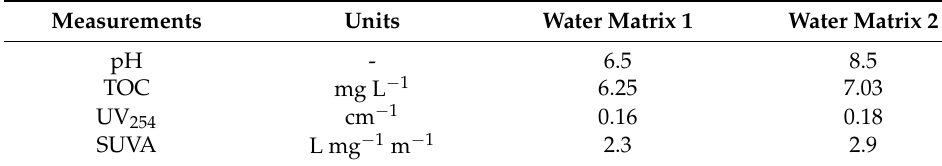
Table 3. Physico-chemical characteristics of the standardized water